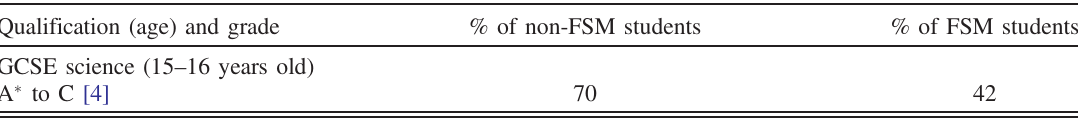
TABLE II. Student performance by free school meal (FSM) status in 2015. GCSE science includes physics, chemistry, and